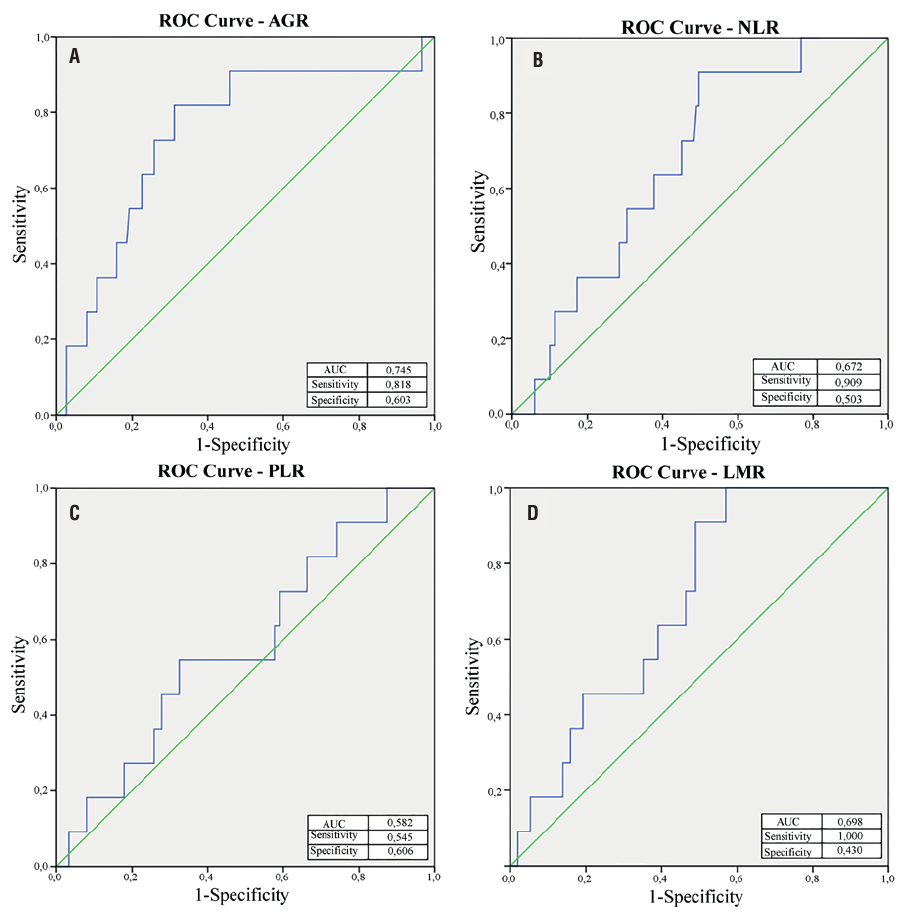
Figure 2 - Optimal cut-off levels for (A) albumin / globulin ratio (AGR), (B) neutrophil / lymphocyte ratio, (C) platelet / lymphocyte ratio (PLR), and (D) lymphocyte /monocyte ratio(LMR) were applied with receiver operating characteristic (ROC) curves for overall